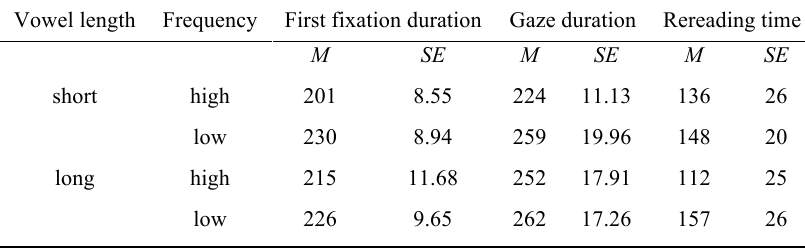
Mean first fixation durations, gaze durations, and rereading time in Experiment 1, a) on target words with short vs. long vowels and of high vs. low frequency, b) on surrounding words as a function of target word vowel length.